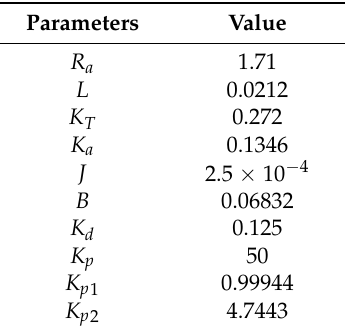
Table 1. DDEA parameters.